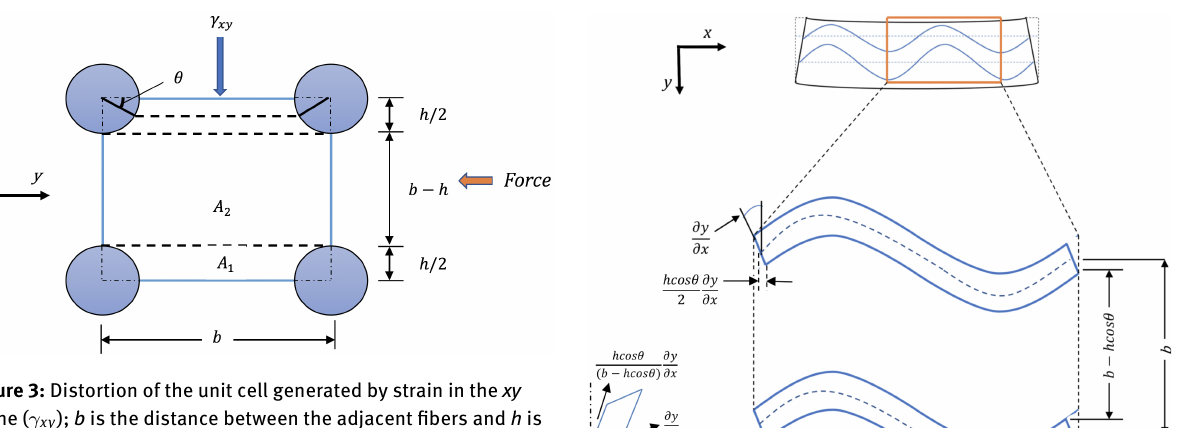
the horizontal direction ( x axis) and h cos θ is the length of the horizontal projection of fiber diameter h parallel to y direction (Figure 5). The magnitude of b